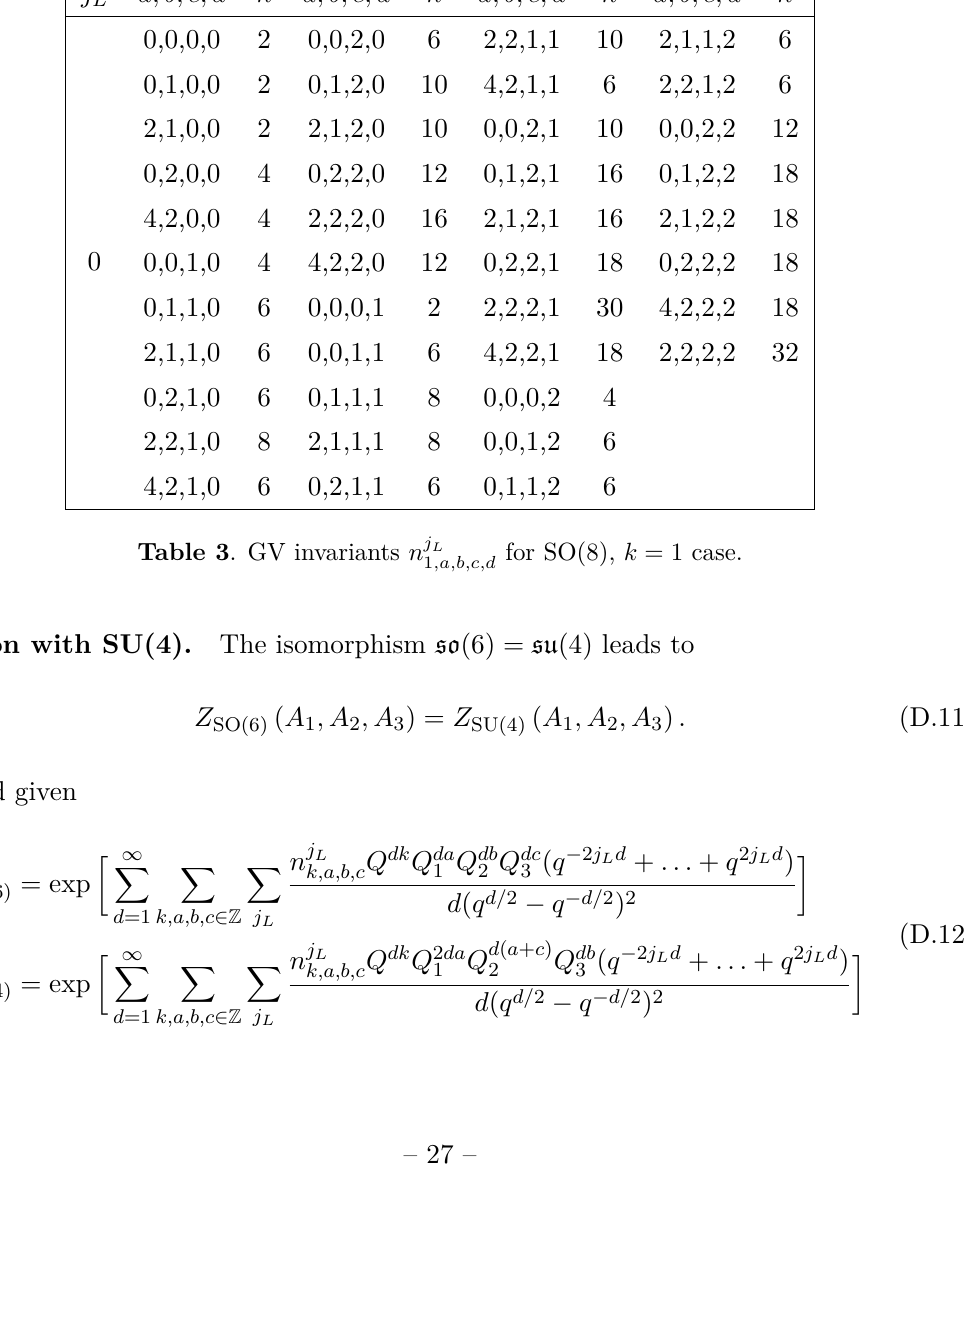
for SO(6) , k = 1 case. 1 ,a,b,c